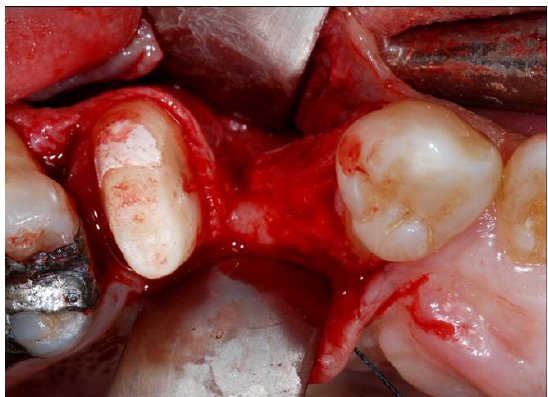
Figure 2. Intraoperative view of the surgical defect after elevation of full-thickness flap.